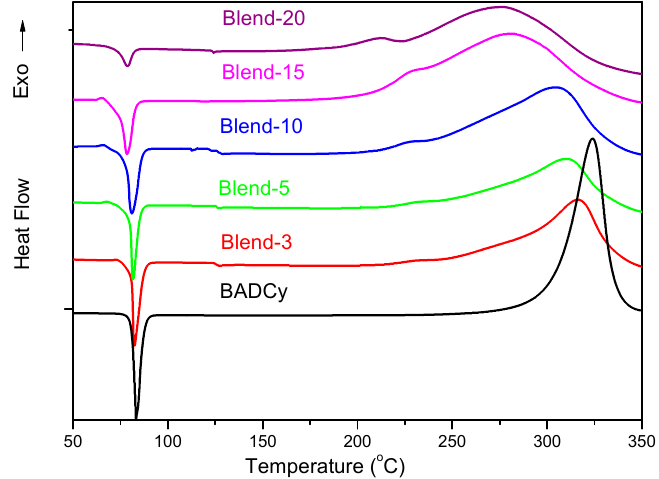
Figure 4. DSC traces of BADCy and TPI/BADCy blends.